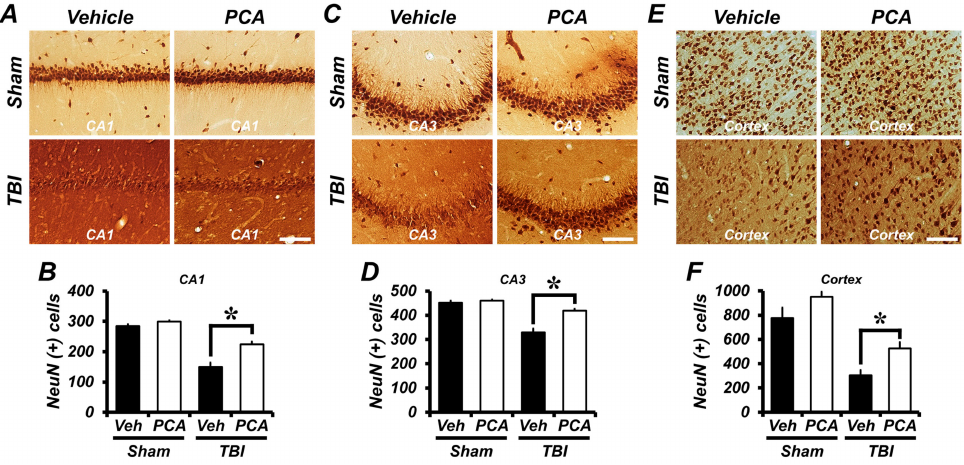
Figure 5. PCA prevents delayed neuronal death after TBI. ( A , C , E ) Representative images show the live neurons in the CA1 ( A ), CA3 ( C ), and cortex ( E ) at one week after Sham operation or TBI surgery. Sham-operated groups did not show neuronal loss. However, the number of NeuN (+) neurons was significantly decreased in the CA1, CA3, and cortex after TBI. In addition, PCA-treated TBI group showed more NeuN (+) neurons when compared to the vehicle-treated TBI group. ( B , D , F ) The bar graphs show the quantified number of NeuN (+) neurons in the CA1 ( B ), CA3 ( D ), and cortex ( F ) after TBI. Data are mean ± SEM, n = 5 from each sham group and n = 10 from each TBI group. * Significantly different from vehicle-treated group, p <